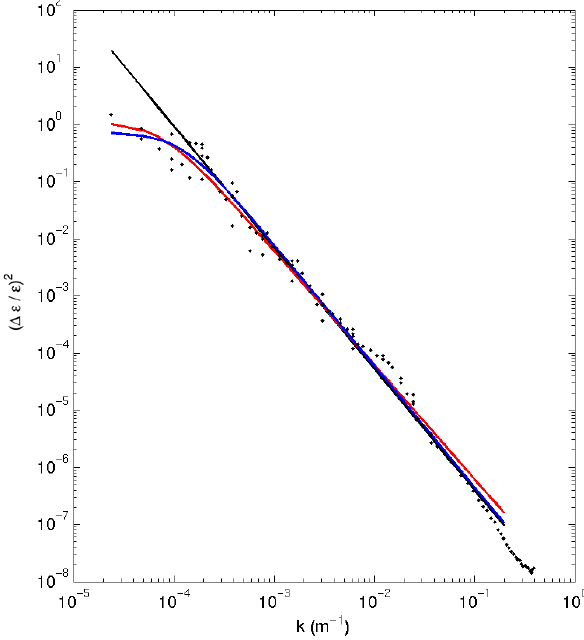
Fig. 4. Example of a 1-D permittivity spectrum (dots), linear fit (black line), fit with a free slope (blue line) and fit with a − 2 fixed slope (red line) following Eq.